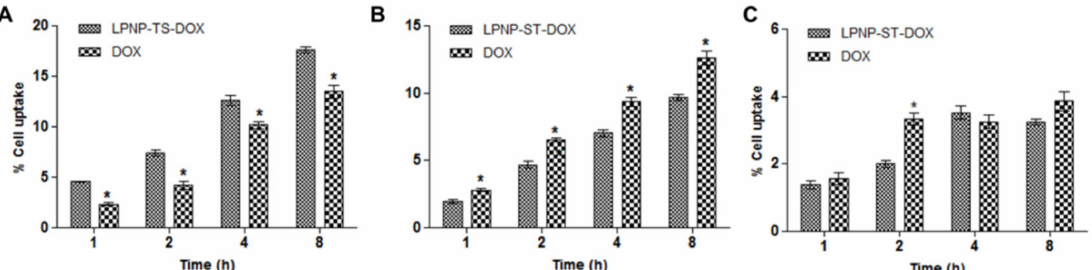
Figure 8. Cellular uptake of free DOX and NLP-TS-DOX evaluated in ( A ) 4T1, ( B ) MDA-MB-231, and ( C ) MCF-7 cell lines. Results are presented as the mean of at least three independent experiments and error bars represent SD. Statistically significant differences between the complexes at the same time point are indicated by asterisks ( p <